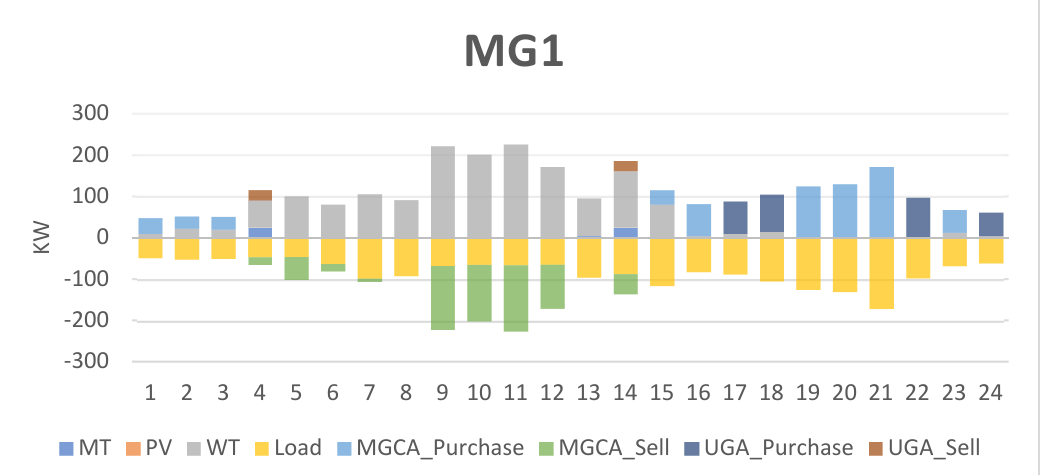
Figure 11. Change in the production power of each unit and the power bought and sold in microgrid 1.